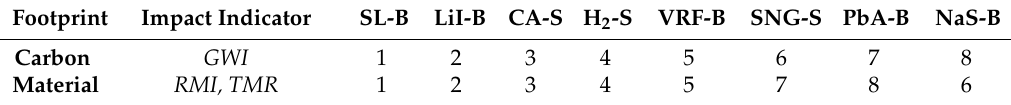
Table 2. Ranking of electrical energy storage technologies regarding carbon and material footprint.